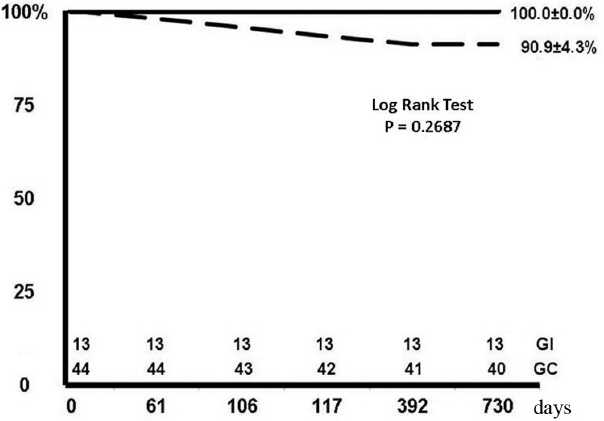
Fig. 1 - Kaplan-Meier actuarial death-free survival curve in the patients from the Intervention Group (continuous line; IG) versus patients from the Clinical Group (dashed line; CG) after primary percutaneous coronary